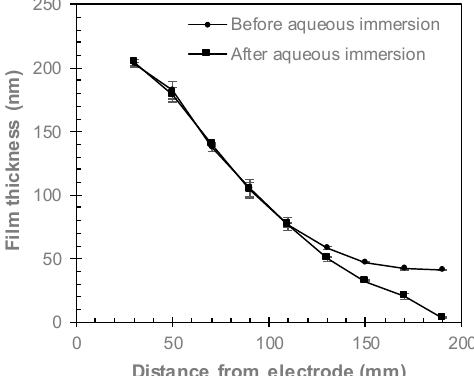
Figure 2. Ellipsometry film thicknesses of ppAAc films before and after immersion in Milli-Q for 18 h as a function of distance from the electrode (error bars ± standard deviation).